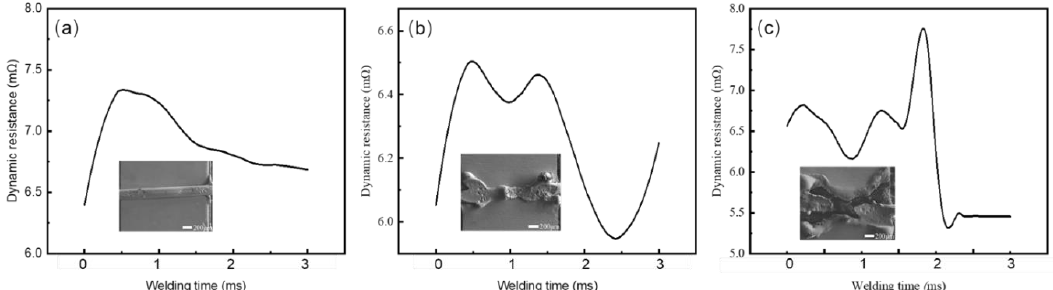
Figure 7. Dynamic resistance curves during the welding process at ( a ) 0.200 kA, 3 ms, and 9.8 N; ( b ) 0.275 kA, 3 ms, and 28.7 N; and ( c ) 0.275 kA, 6 ms, and 9.8 N. The inset images are the corresponding morphologies. The parameters correspond with designations a, m, and d in Table 1,